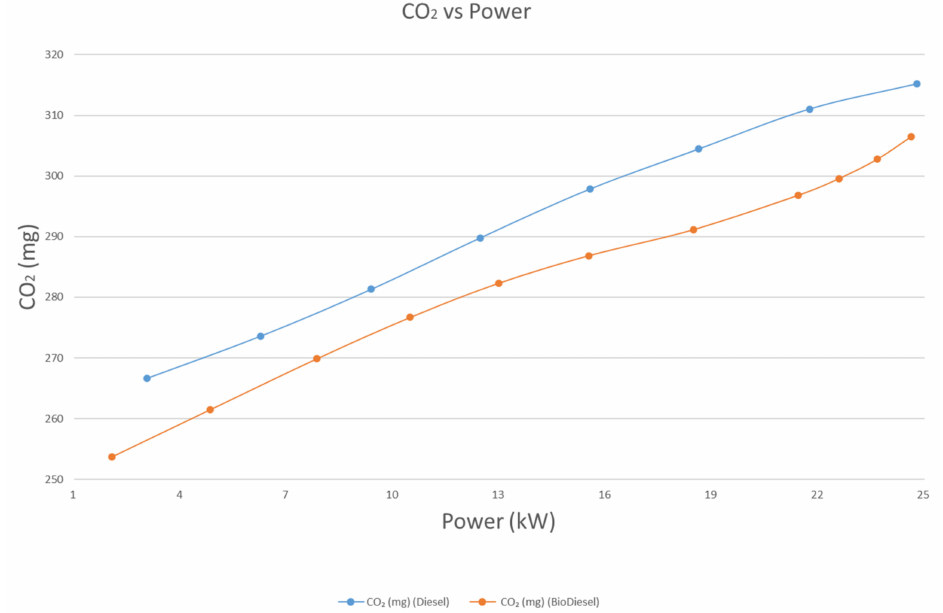
Figure 19. CO 2 vs.